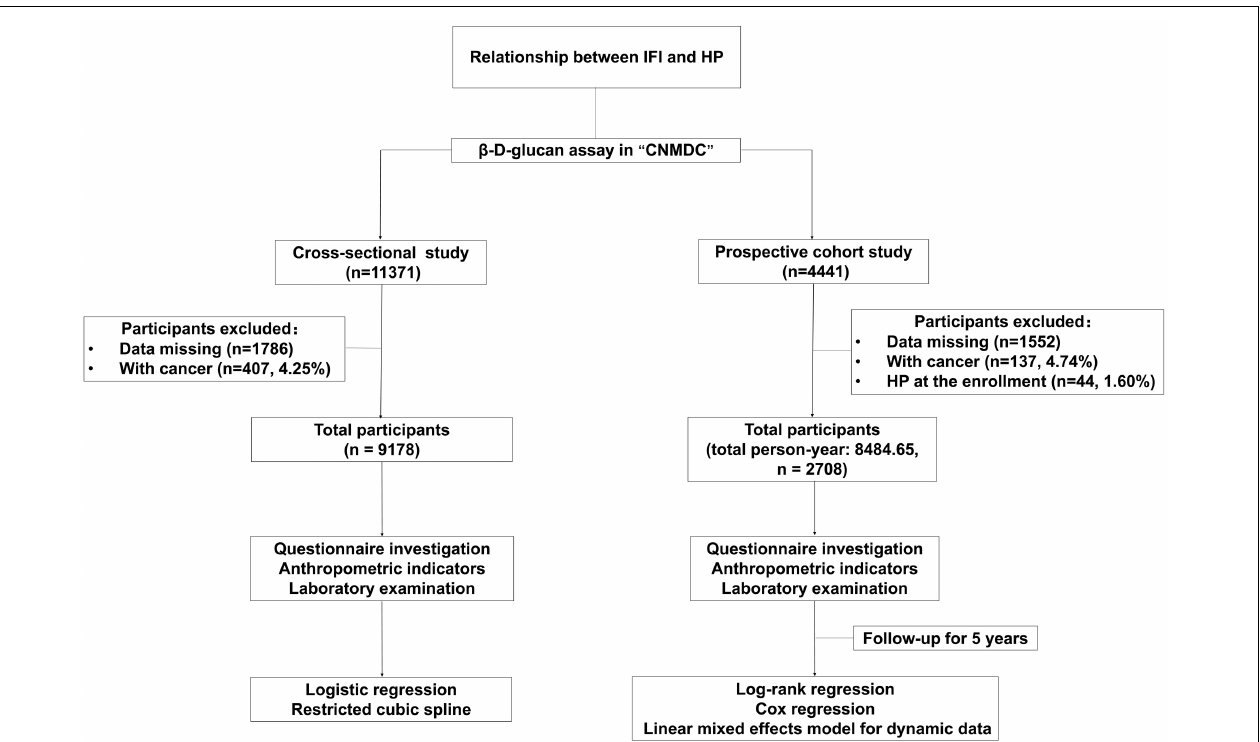
FIGURE 1 | Flow chart for the cross-sectional and prospective cohort study. IFI, invasive fungal infection; HP, hypostatic pneumonia.